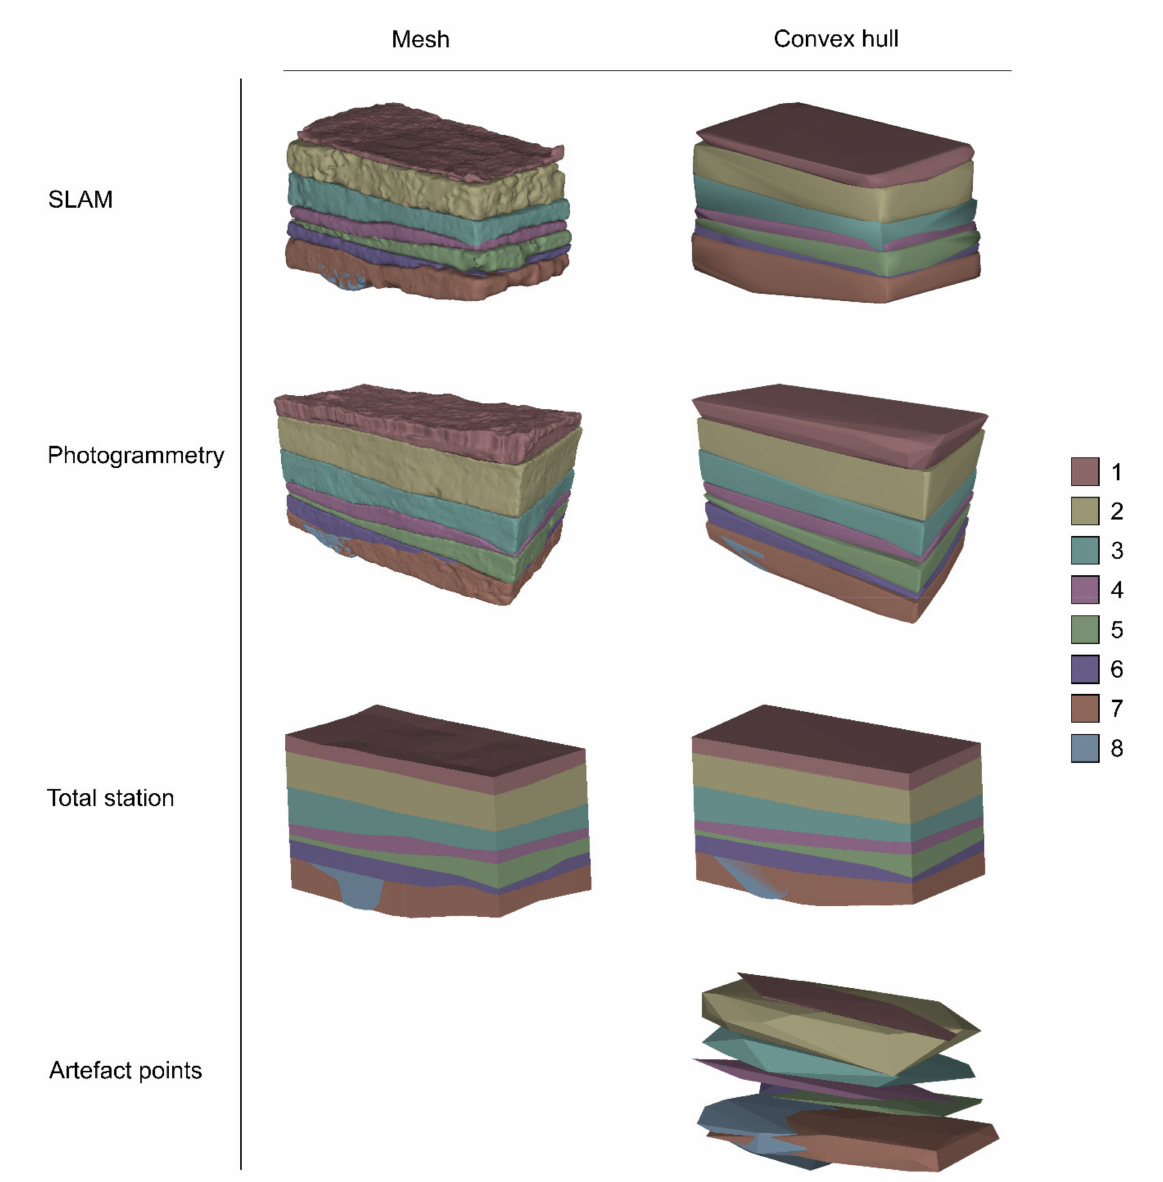
Figure 5. 3D views of EA231 from the different methods